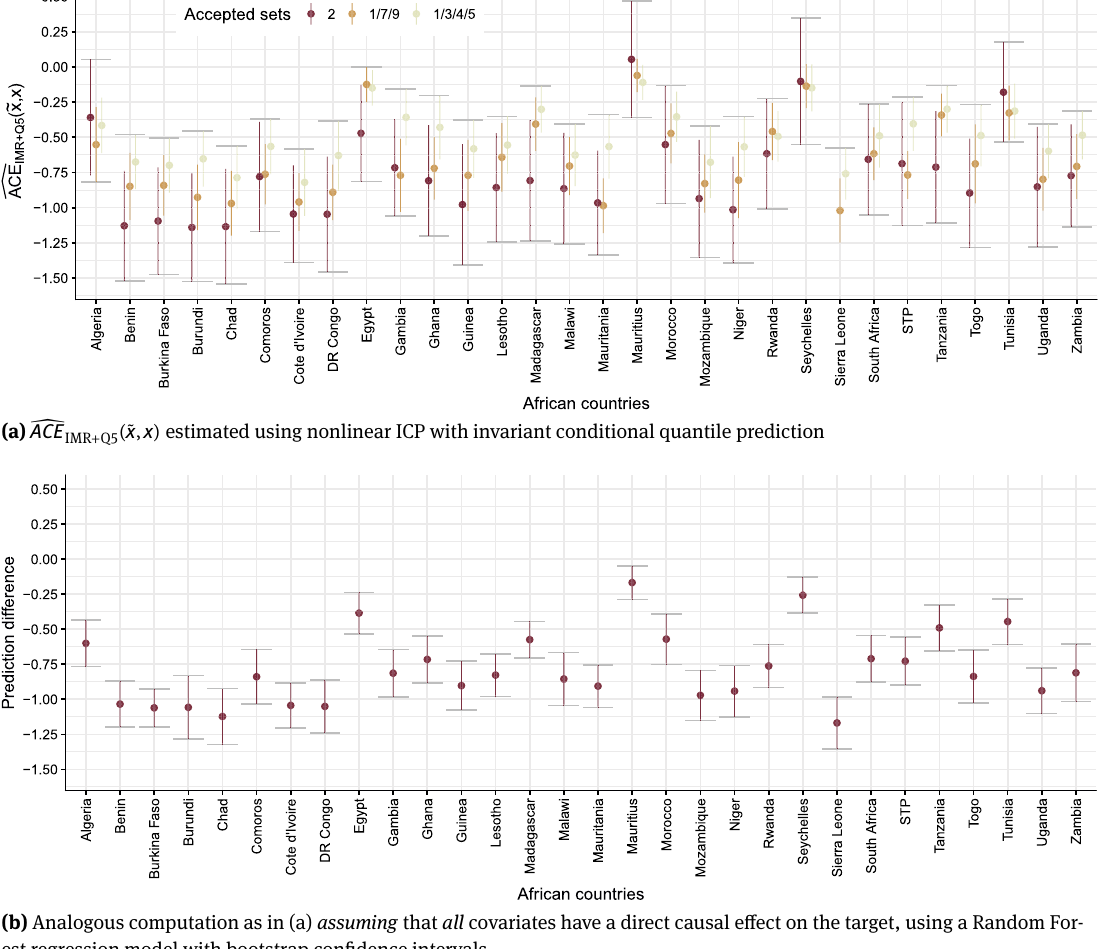
Figure 3: (a) Bounds for the average causal effect of setting the variables IMR and Q5 in the African countries in 2013 to Euro- pean levels, that is ̃ x differs from the country-specific observed values x in that the child mortality rates IMR and Q5 have been set to their respective European average. The implied coverage guarantee is 80% as we chose α = 0 . 1. (b) Random Forest re- gression model using all covariates as input. The (non-causal) regression effect coverage is again set to 80%. We will argue below that the confidence intervals obtained by random forest are too small, see Table 1 and Figure